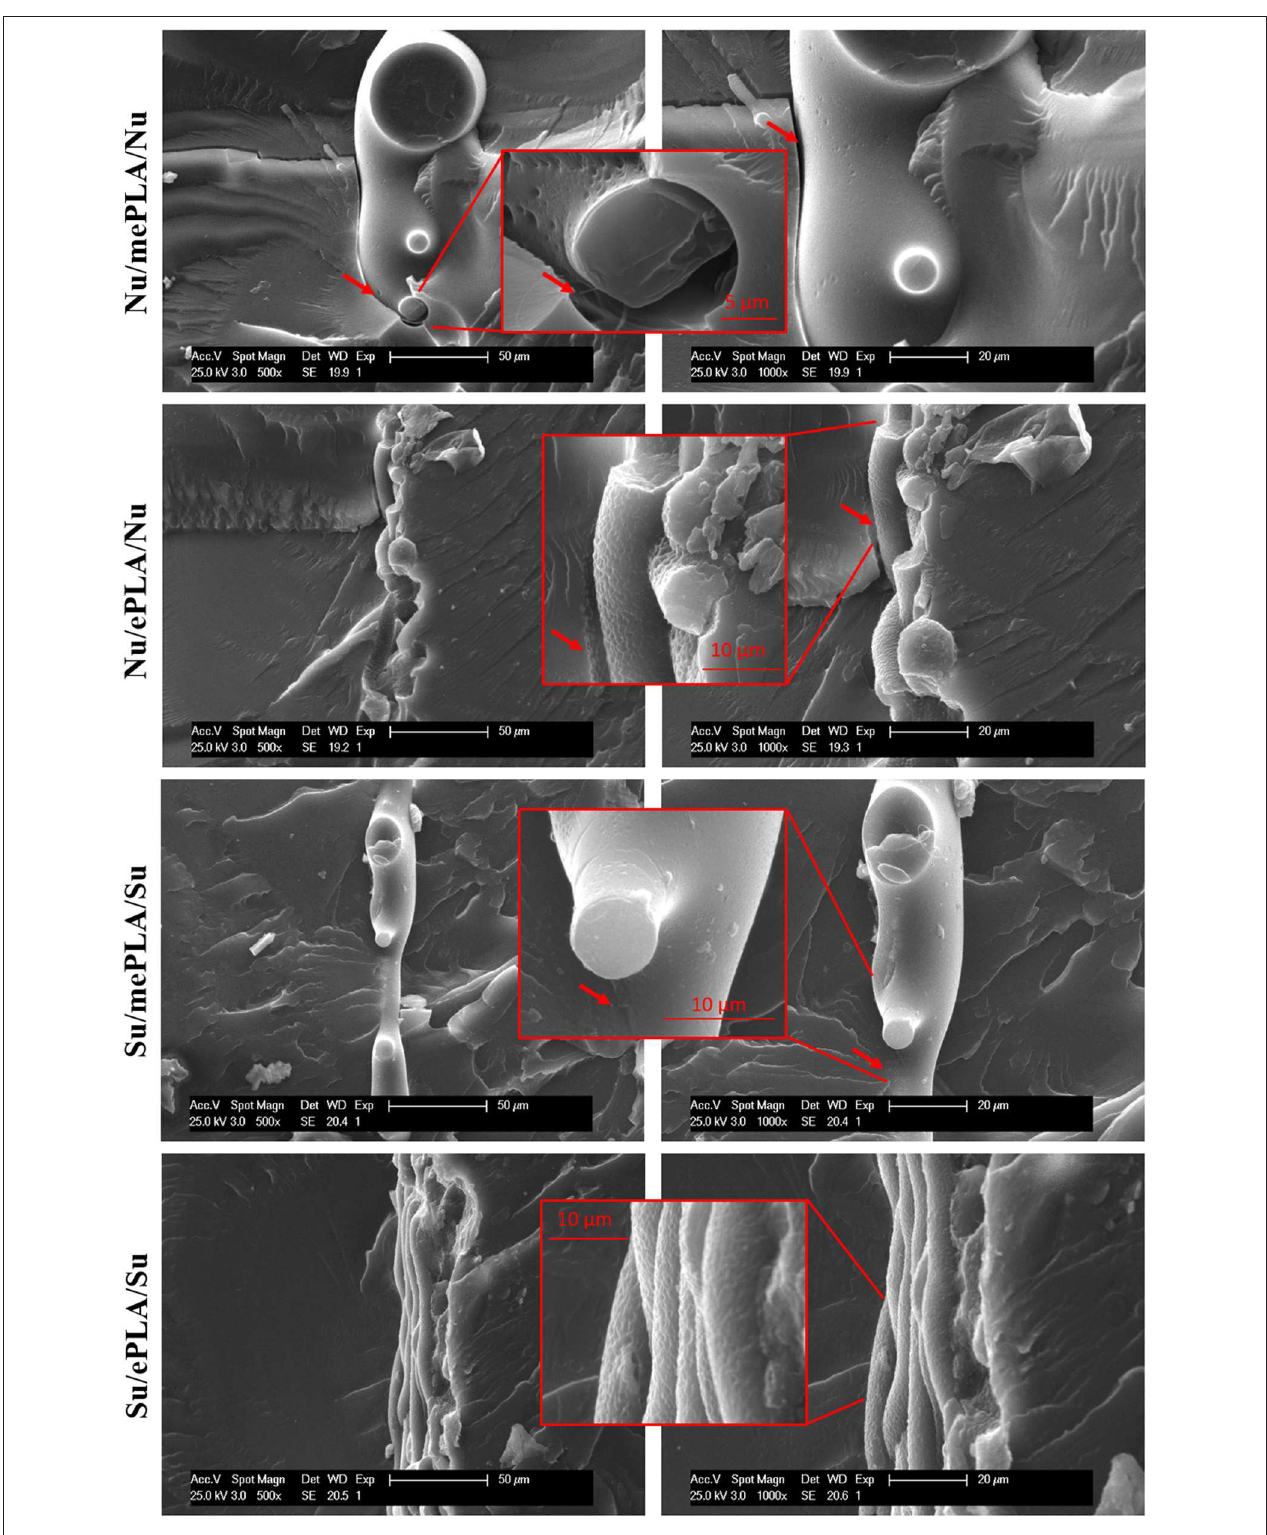
FIGURE 4 | SEM images of the cross-section of Nucrel- and Surlyn-based multilayer composites reinforced with PLA electrospun microfibers.